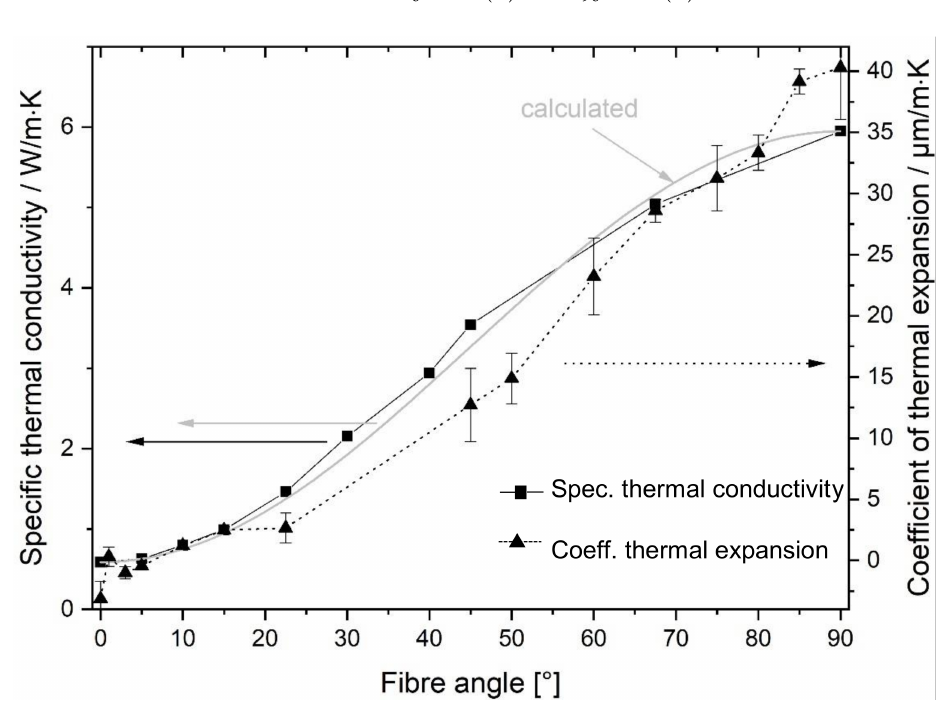
Figure 5. Thermal conductivity at 15 ◦ C, additionally calculated according to Equation (1) and thermal expansion coefficient of CFRP with given out-of-plane fibre